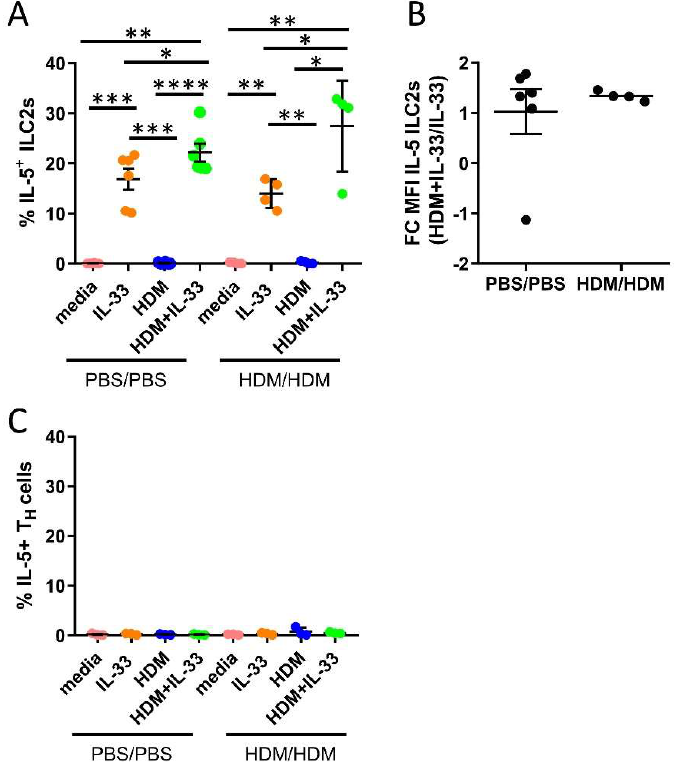
Figure 4. IL-5 production by bone marrow ILC2s and T H cells from ex vivo stimulations for 24 h. ( A ) Number of IL-5 + cells among ILC2s. ( B ) Fold change (FC) mean fluorescence intensity (MFI) of IL-5 in ILC2s from HDM + IL-33 stimulated bone marrow cultures compared to IL-33 stimulated bone marrow cultures. ( C ) Number of IL-5 + cells among T H cells. Data are representative of 1–2 independent experiments (n = 3–6/group). PBS/PBS = controls. HDM/HDM = HDM-sensitized and challenged. Media = control. Paired t-test. * p < 0.05, ** p < 0.01, *** p < 0.001 and **** p < 0.0001.